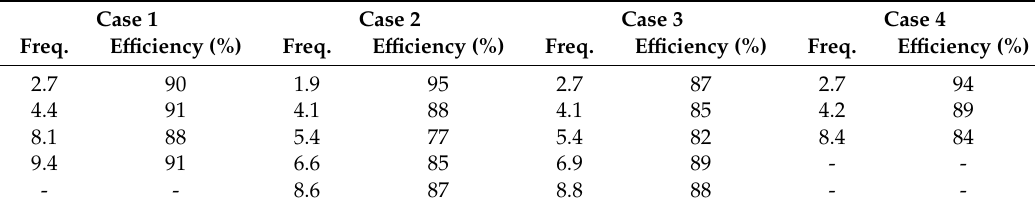
Table 8. Radiation E ffi ciency (%) in all four cases at resonance frequencies.